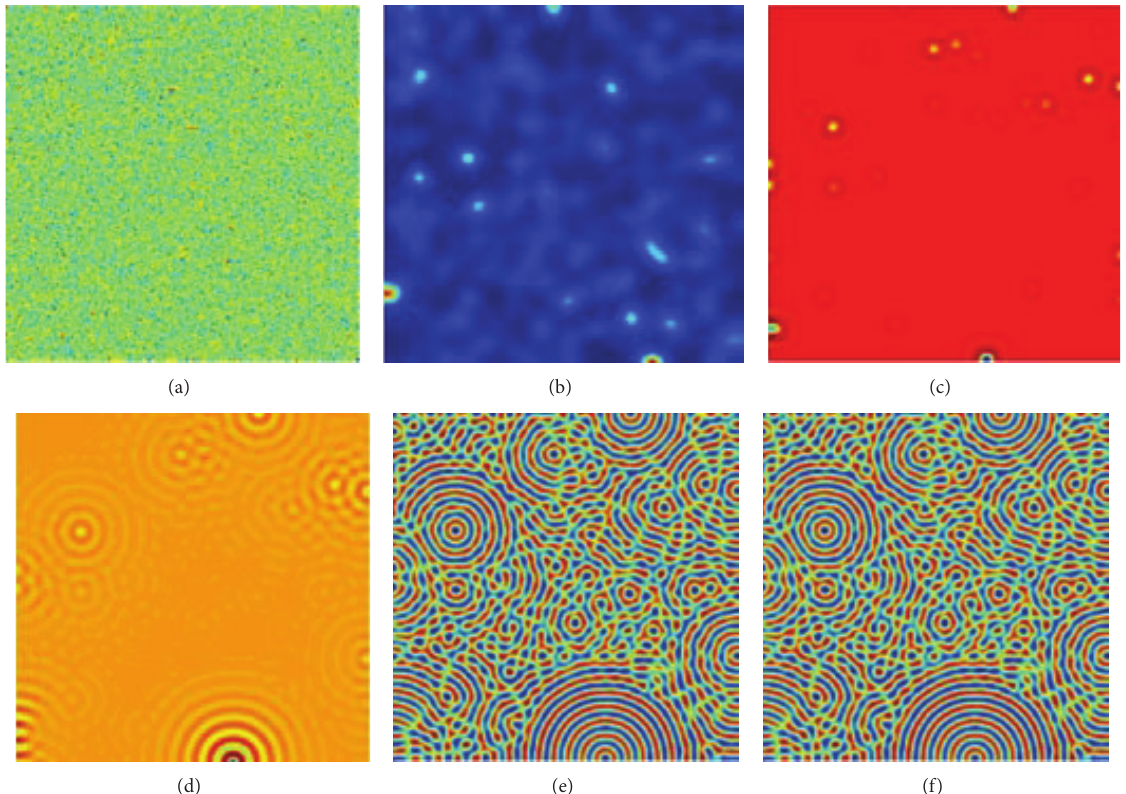
Figure 7: Spatial pattern of prey population at different time. Parameters set: 𝛾 = 1.5 , 𝜀 = 0.15 , and 𝛿 = 1.2 . (a) 𝑡 = 0 ; (b) 𝑡 = 100 ; (c) 𝑡 = 200 ; (d) 𝑡 = 300 ; (e) 𝑡 = 400 ; and (f) 𝑡 = 500